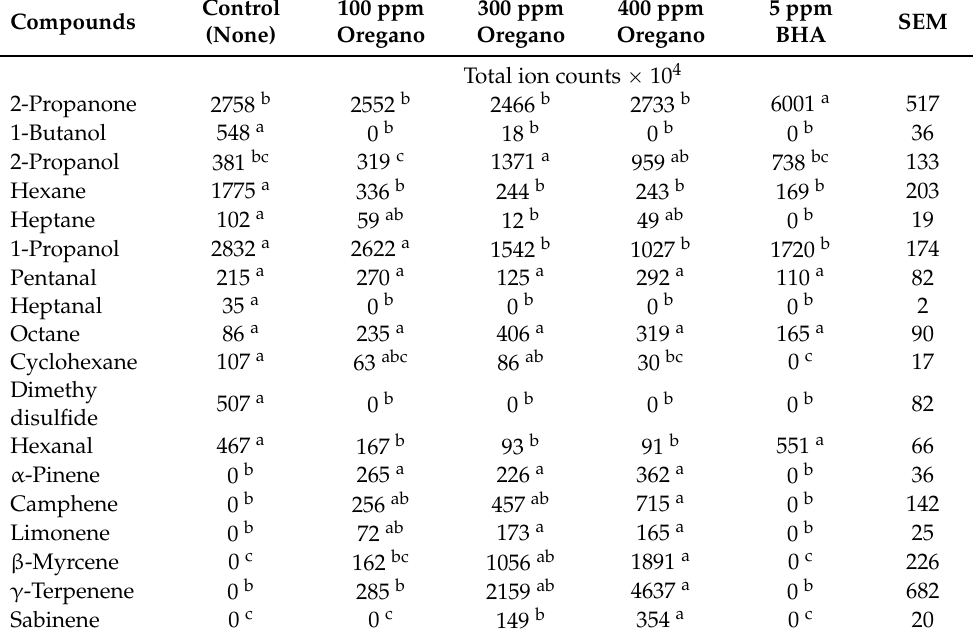
Table 4. Profile of volatiles from cooked chicken breast meat with different levels of oregano oil at day 0. Control Compounds (None)